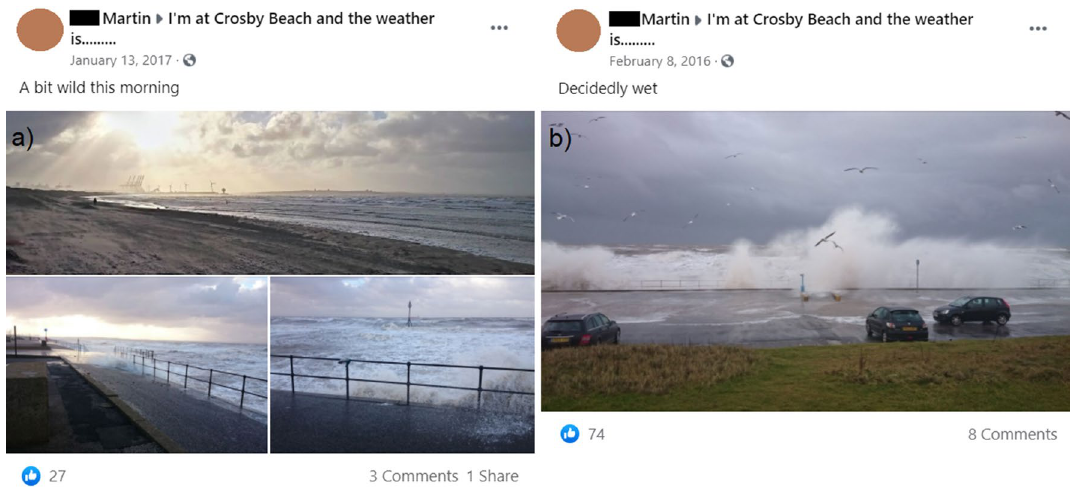
Figure 2. Facebook posts by author A. Martin showing examples of different severity wave overtopping at Crosby between 2013 and 2017. ( a ) Low magnitude overtopping over the promenade and ( b ) extreme overtopping posing a hazard to the car park.